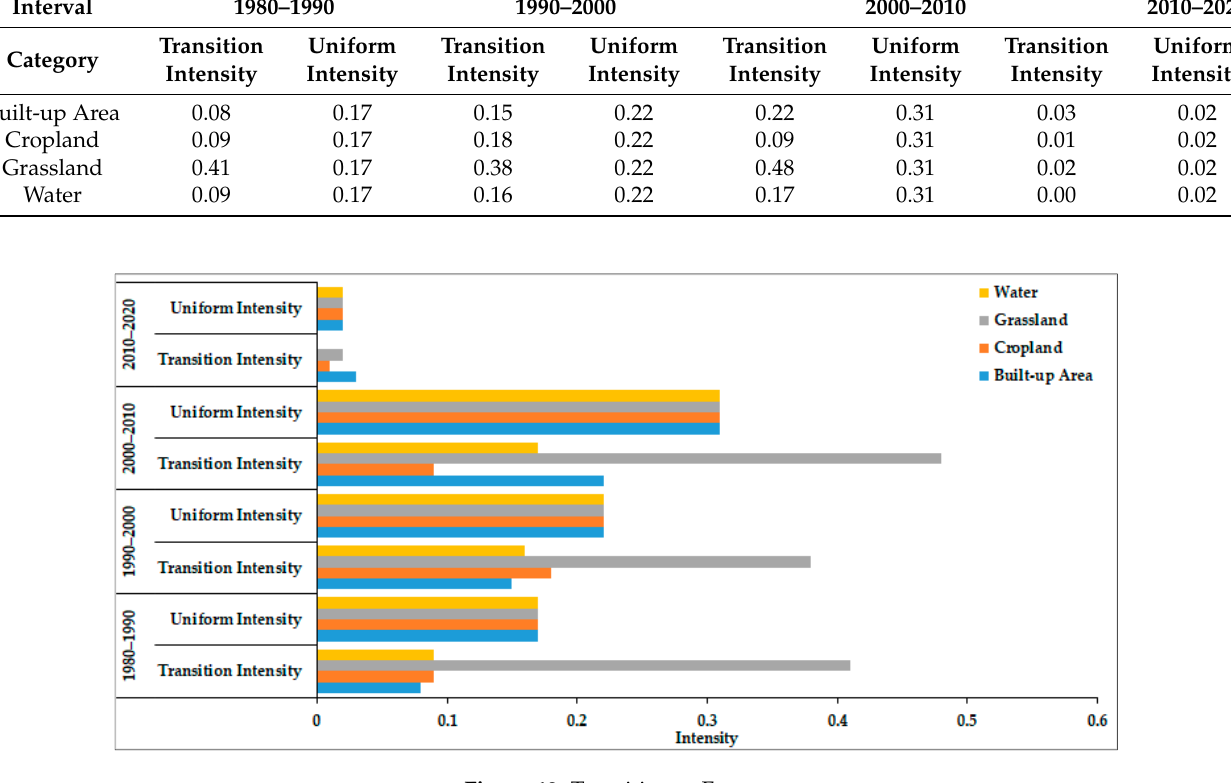
Figure 12. Transition to Forest. Table 22 and Figure 13 show the transition intensity of other categories to cropland.